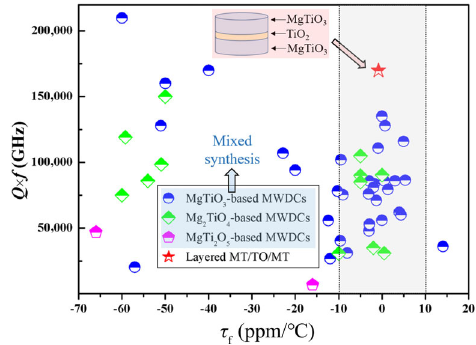
Summary of Q × f value versus τ f plot for MgO–TiO 2 system MWDCs. Reproduced with permission from Ref. [4], © Elsevier Ltd and Techna Group S.r.l.